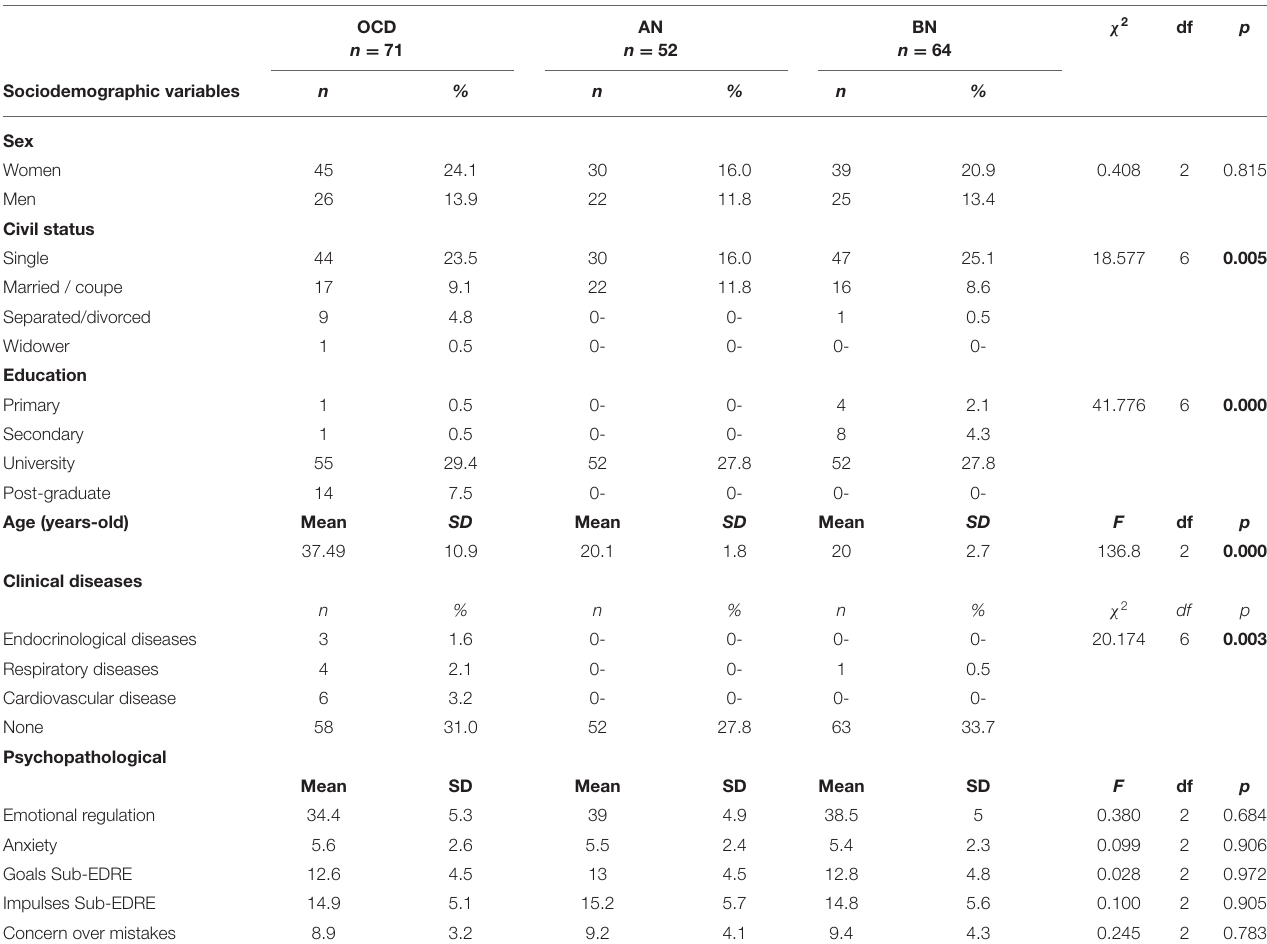
TABLE 1 | Description of the sample.